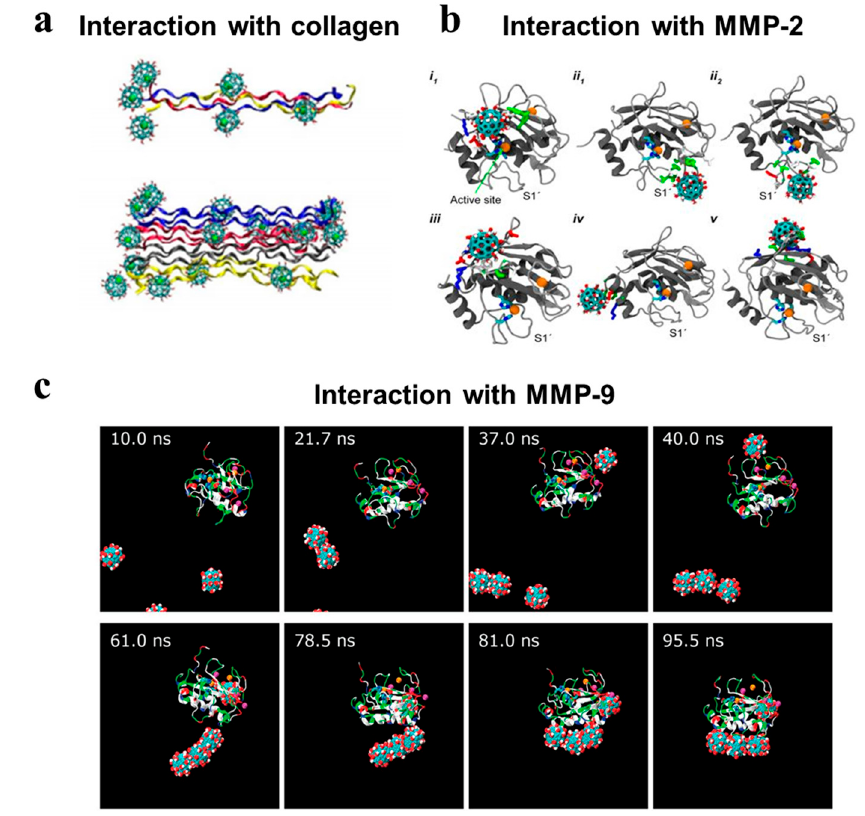
Figure 3. Molecular dynamics of Gd@C 82 (OH) 22 interacting with key ECM-associated biomolecules.